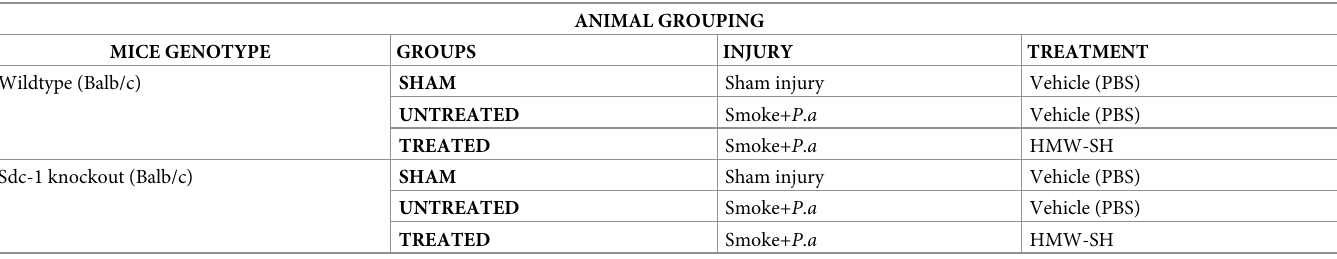
Table 1. Animal groups, injury, and